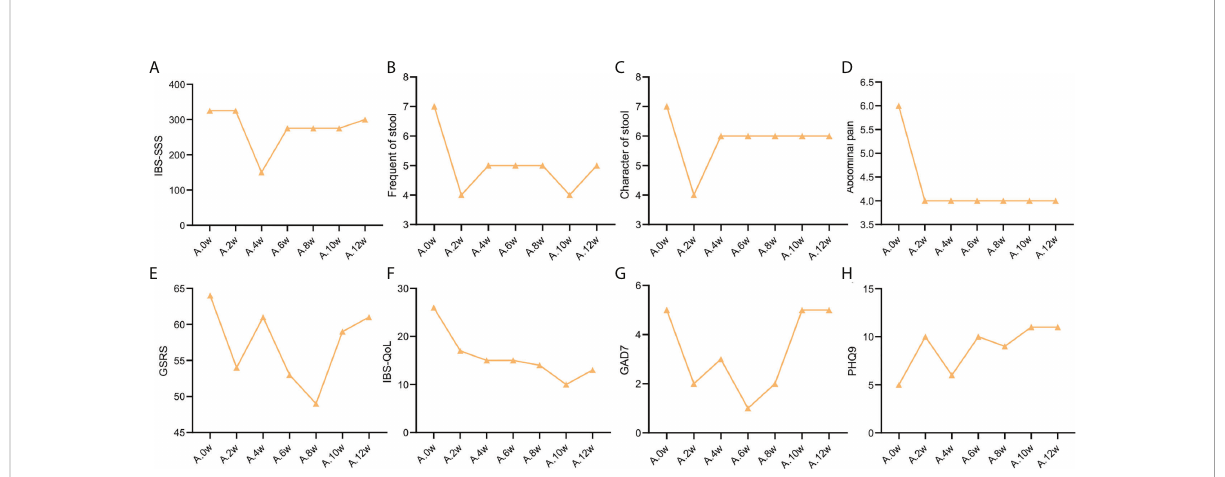
FIGURE 1 Change trend of IBS clinical indicators of patient case 1. (A) . IBS-SSS score. (B) . stool frequency. (C) . Character of stool. (D) . Abdominal pain score. (E) . GSRS. (F) . IBS-QoL. (G) . GAD7. (H) .